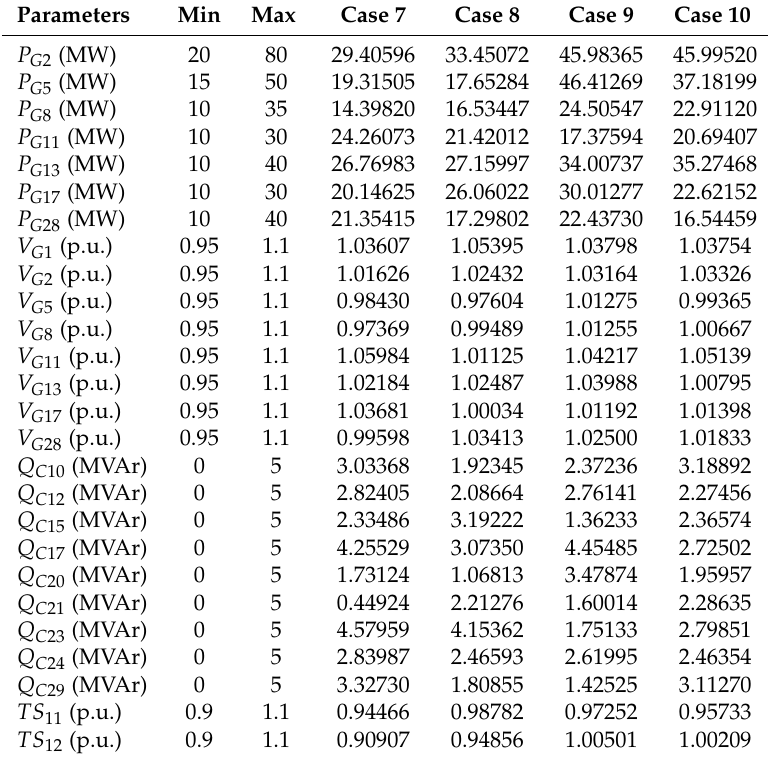
Table A12. Optimal solutions obtained by GROM for multi-objective OPF for IEEE 30-bus Modified